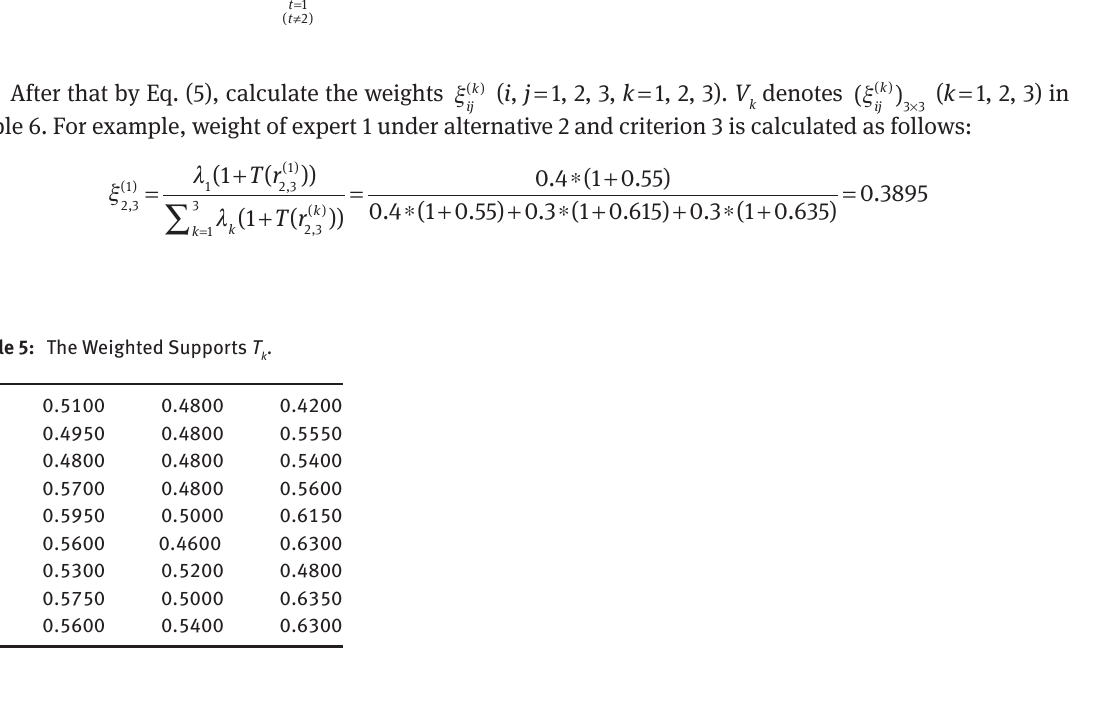
Table 6. For example, weight of expert 1 under alternative 2 and criterion 3 is calculated as follows: